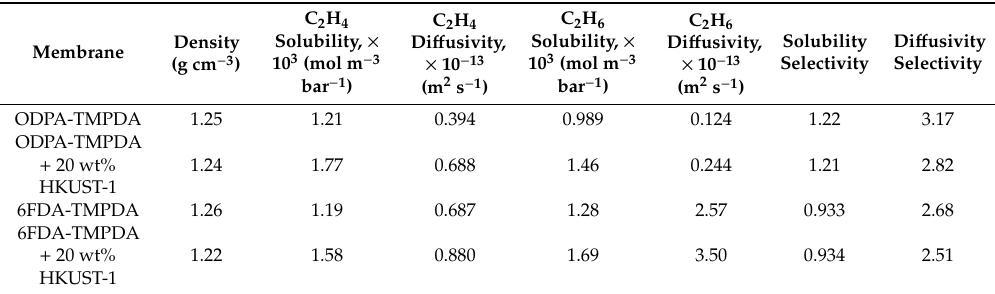
Figure 6. Adsorption isotherm of ( a , c ) C 2 H 4 and ( b , d ) C 2 H 6 of pure polymeric and mixed-matrix membranes. Table 2. C 2 H 4 and C 2 H 6 solubility and di ff usivity parameters of pure polymeric and mixed-matrix membranes at 35 ◦